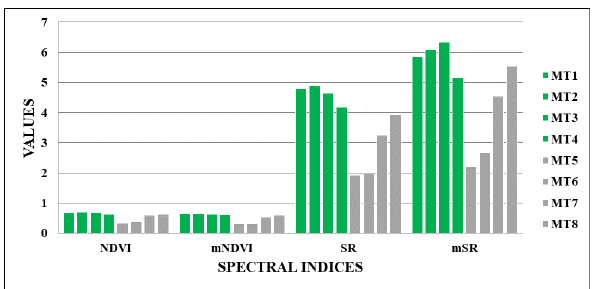
Figure 8.Spectral response curve for four different mango trees outside campus